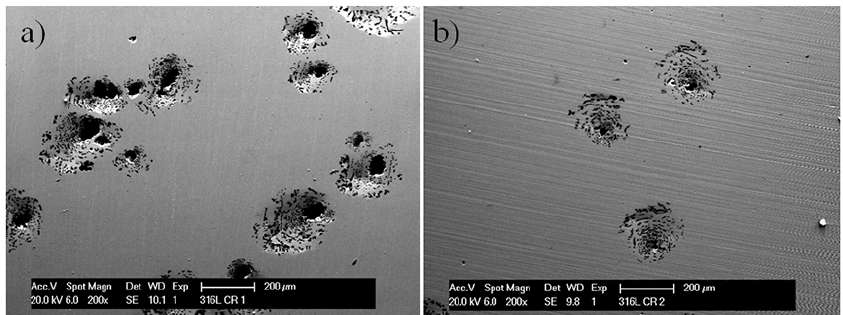
Figure 12 . SEM image of the pit density for the alloy 316L in the as-received condition in an aqueous medium (oil field formation water) a) with CO